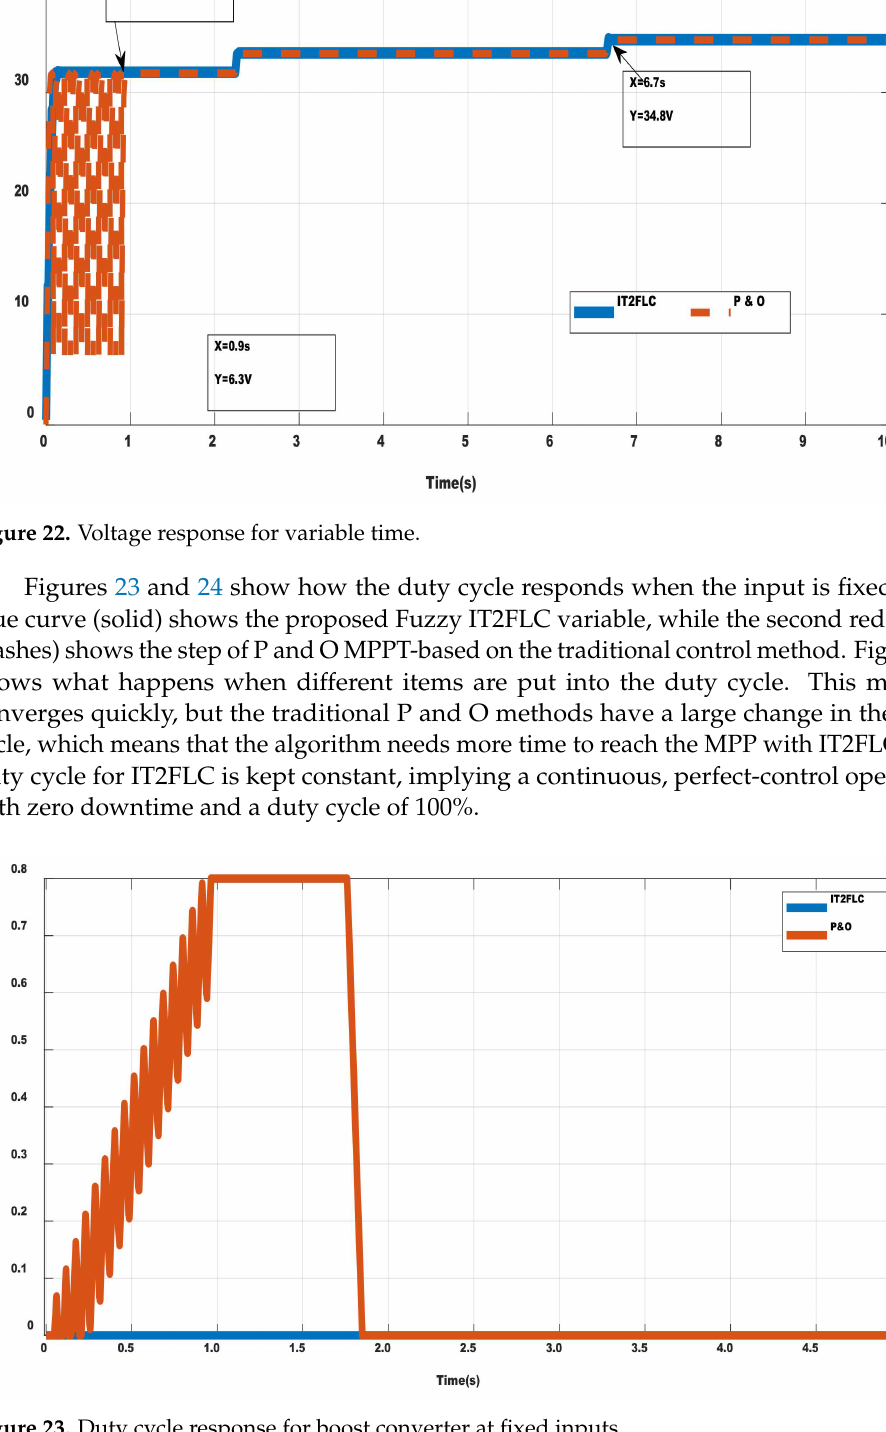
Figure 23. Duty cycle response for boost converter at fixed